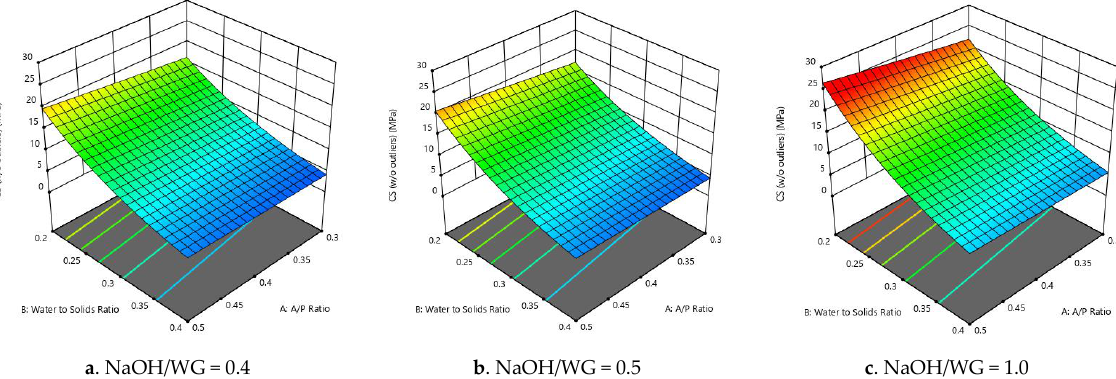
Figure 4. ( a – c ) Compressive strength vs. water-to-solids ratio and A/P ratio for each NaOH/WG ratio value.